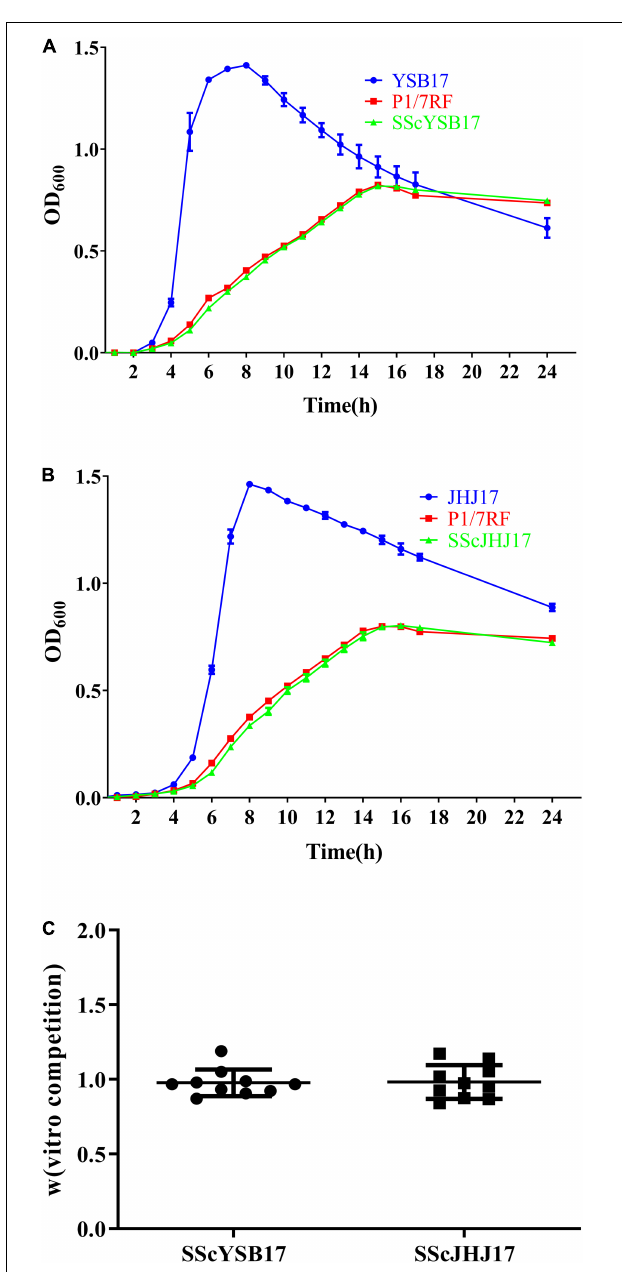
FIGURE 2 | The biological cost of the horizontal acquisition of ICE Ssu YSB17_ rplL or GI Ssu JHJ17_ rpsI . (A) Growth curves of the YSB17, P1/7RF, and SScYSB17 under the same conditions in vitro . (B) Growth curves of the JHJ17, P1/7RF, and SScJHJ17 under the same conditions in vitro . (C) The relative competitive fitness W of recipient P1/7RF and two transconjugants SScYSB17 and SScJHJ17 strain. The values are represented as mean ± SD of 10 independent